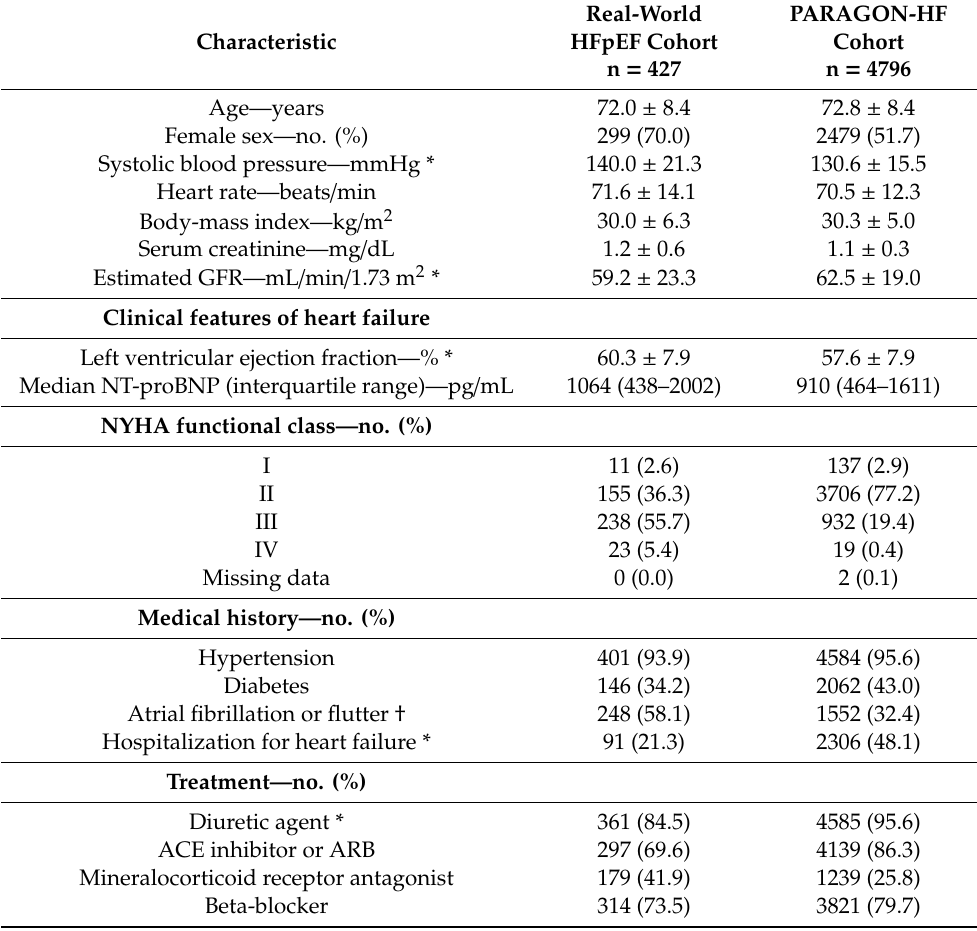
Table 2. Baseline characteristics of the real-world HFpEF cohort as compared to PARAGON-HF. Characteristic